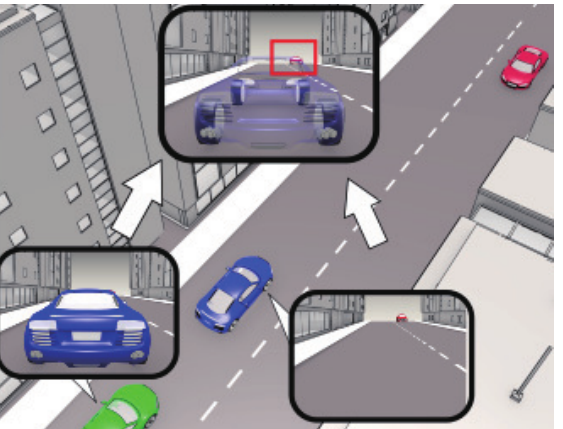
Figure 1. An illustration of the concept of cooperative perception. Although the red oncoming vehicle is invisible to the green ego vehicle due to the blue vehicle blocking it, the cooperative perception between the ego vehicle and blocking vehicle changes it to